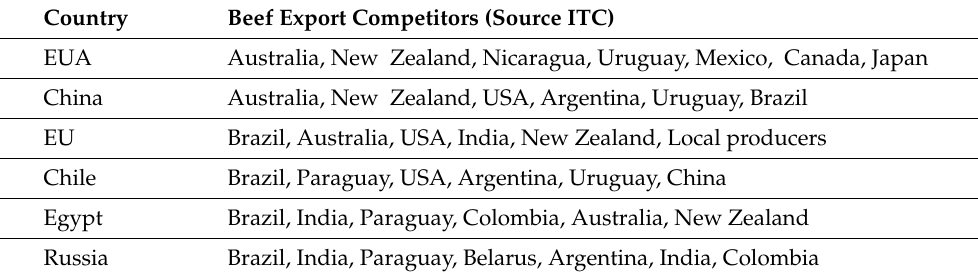
Table 3. Competitors within Consumer Markets.